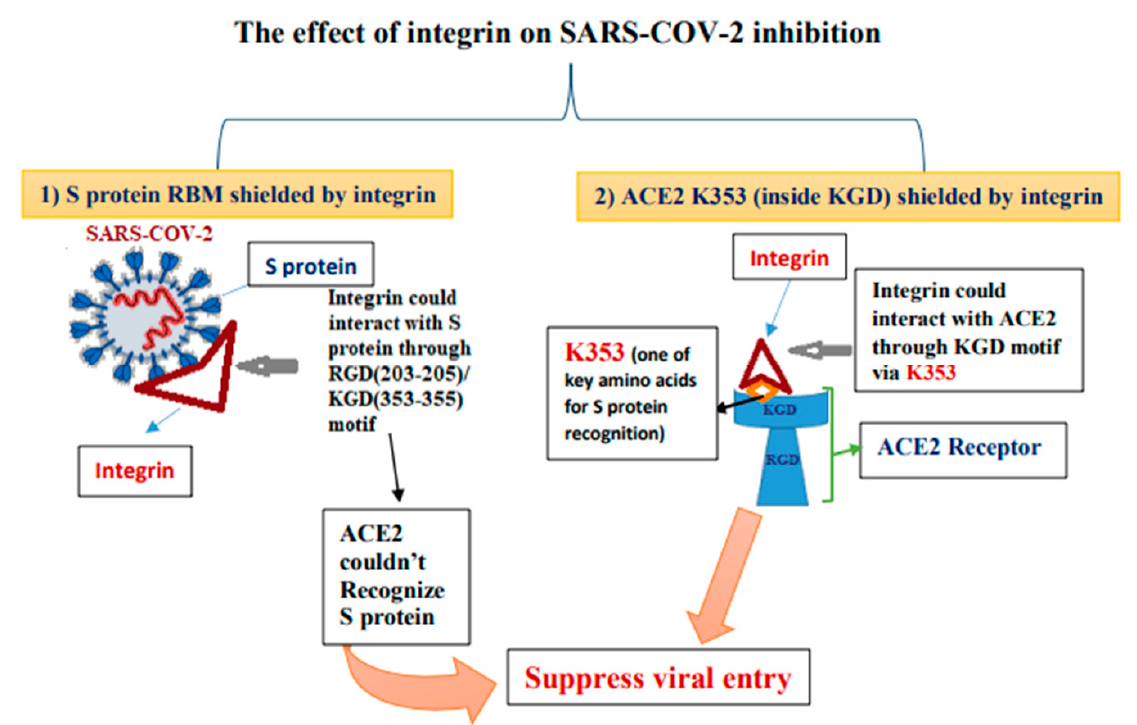
Figure 3. The critical inhibitory role of integrin in SARS-CoV-2.